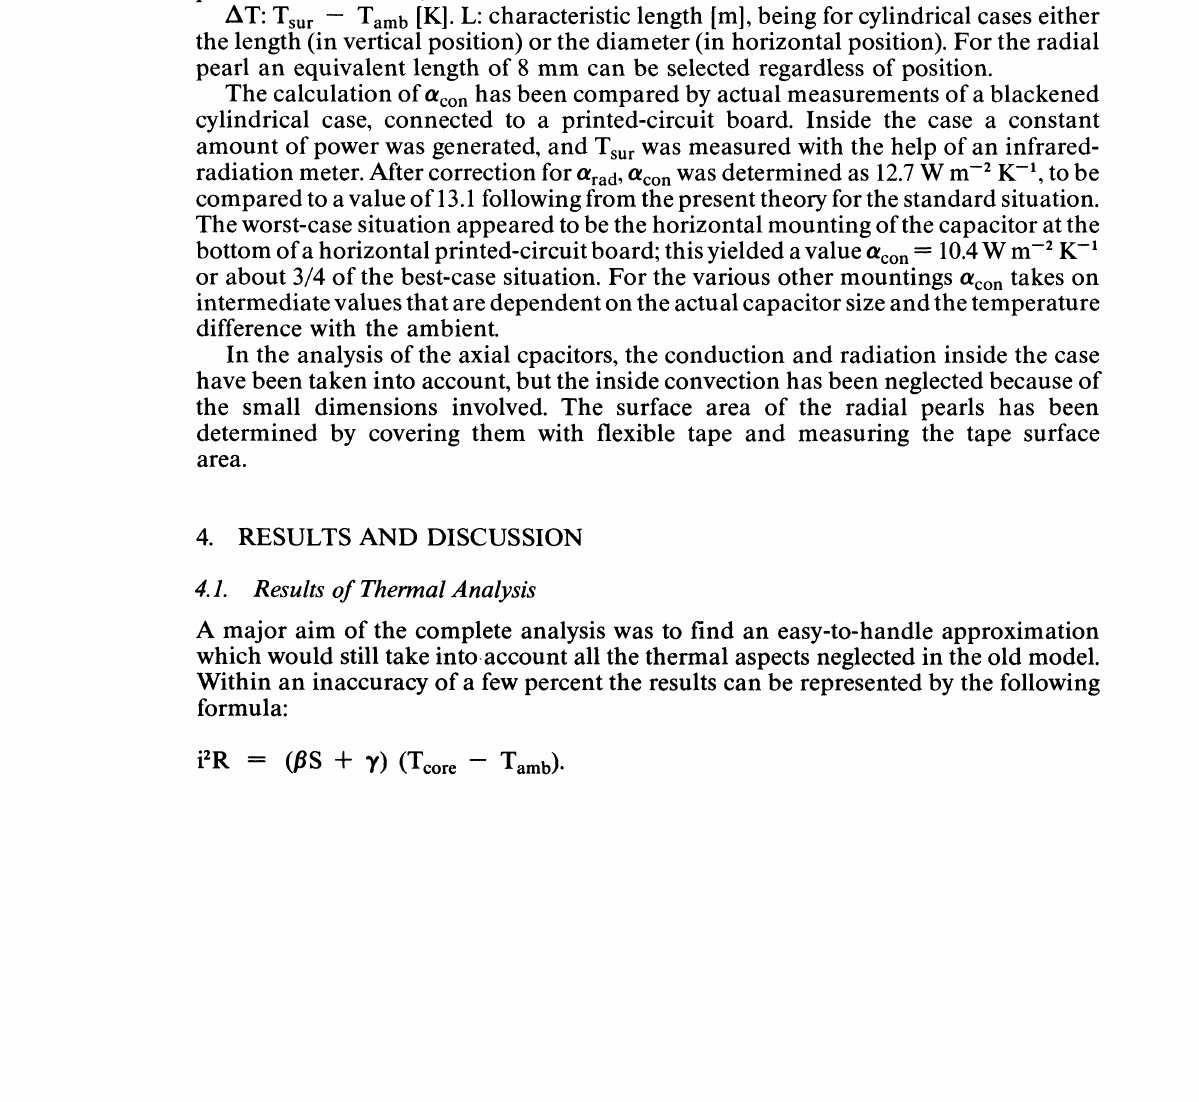
FIGURE 10 Function K in the equation for the convection coefficient, as a function of mean temperature Tm[K], Tm (Tma + Tamb)/2. See Ref. 21, 22 for